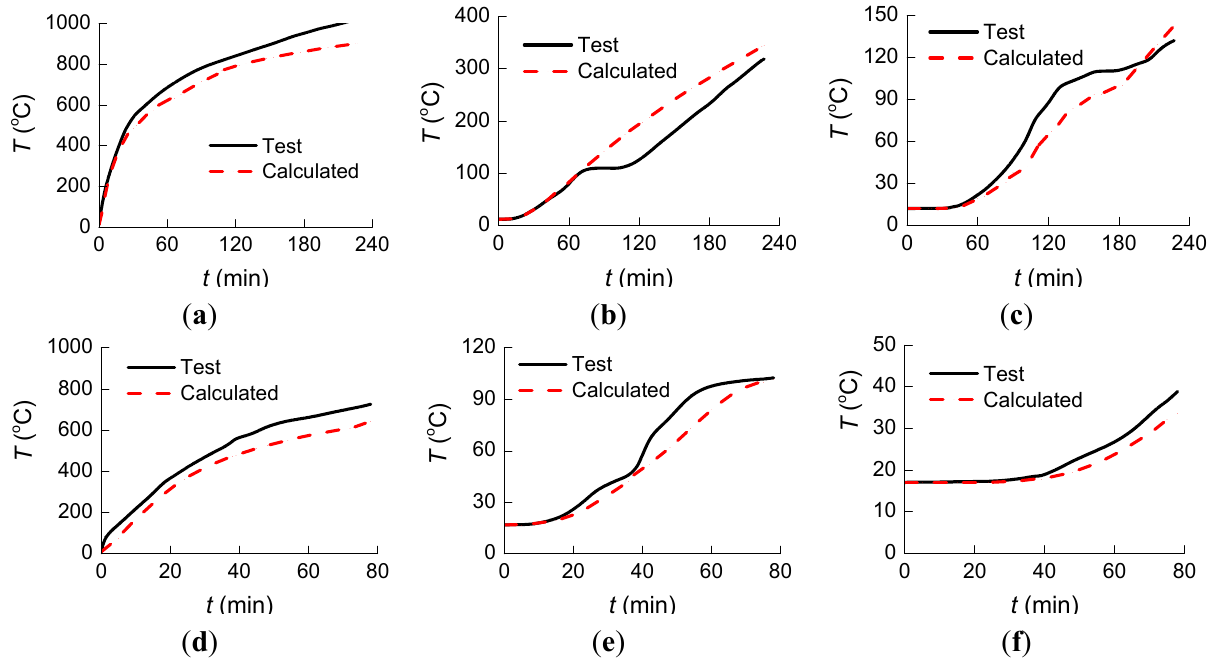
Figure 16. Comparison of temperature between calculated and measured results at the three measure points. NCC-1: ( a ) Measure Point 1; ( b ) Measure Point 2; and ( c ) Measure Point 3. NCC-2: ( d ) Measure Point 1; ( e ) Measure Point 2; and ( f ) Measure Point 3. RCC-1: ( g ) Measure Point 1; ( h ) Measure Point 2; and ( i ) Measure Point 3. RCC-2: ( j ) Measure Point 1; ( k ) Measure Point 2; and ( l ) Measure Point